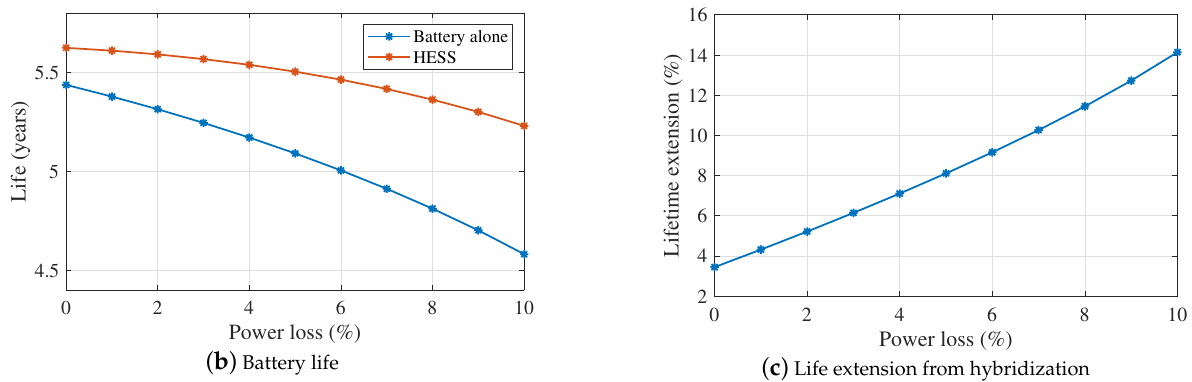
Figure 17. Converter power losses’ effect on battery